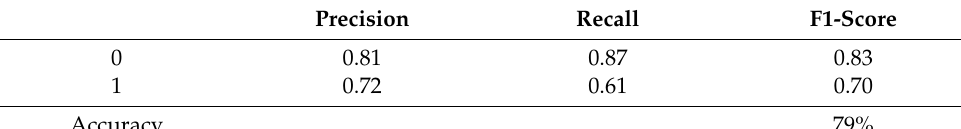
Table 12. Validation of proposed model with K-fold cross-validation without removing outlier values. Precision Recall Precision